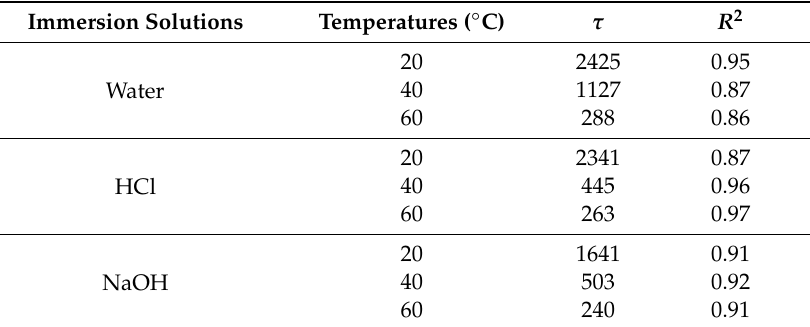
Table 5. Coefficients of regression equations in Equation (4)